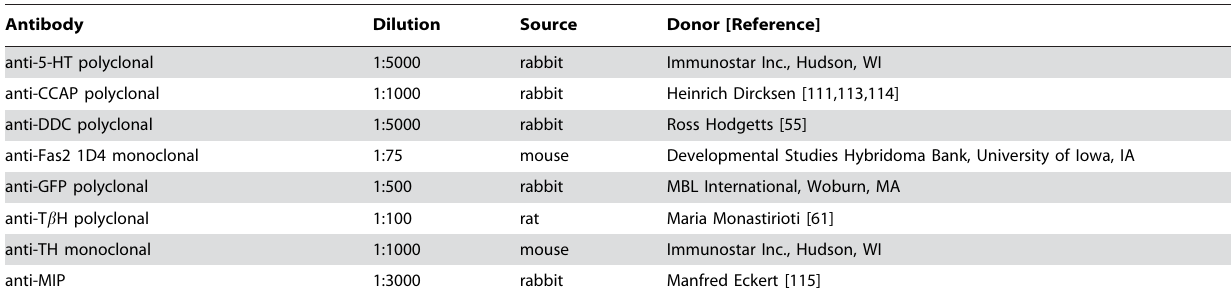
Table 2. Employed antisera.